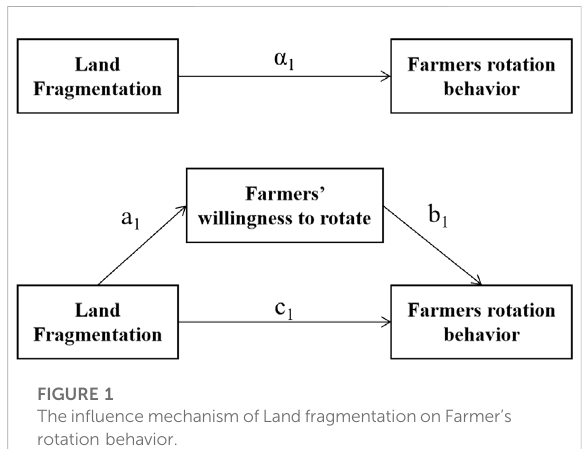
FIGURE 1 The in fl uence mechanism ofLandfragmentationon Farmer ’ s rotation